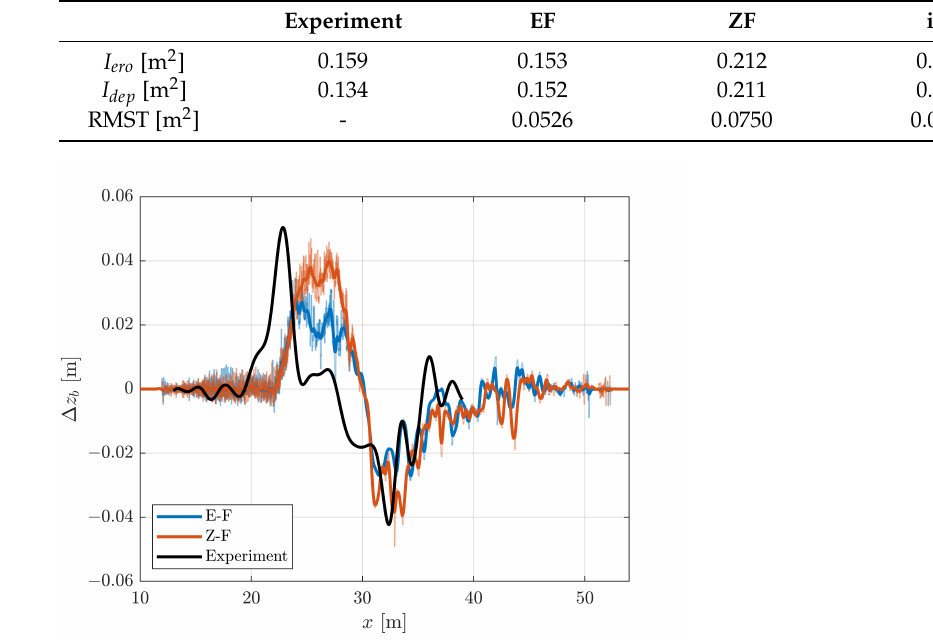
Figure 9. A comparison of measured and modelled bathymetric change produced by the Engelund and Fredsoe [37] (E-F) and Zyserman and Fredsøe [39] (Z-F) models, after three consecutive solitary wave events. The thin line shows the original data and the thick line shows the same data after a Gaussian smoothing